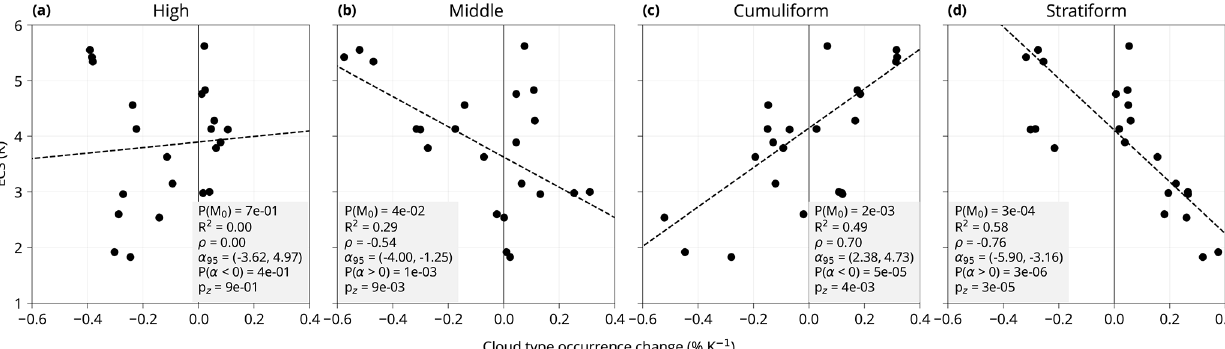
Figure 10. Dependence of model ECS on the cloud type occurrence change with respect to GMST. Confidence bands represent the 68% range. Linear regression is calculated using Bayesian simulation assuming a Cauchy error distribution (Appendix A). Shown is also the probability of the null hypothesis model P ( M 0 ) (explained in Sect. 4.6), the coefficient of determination ( R 2 ), the correlation coefficient ( ρ ), the 95% confidence interval of the slope ( α 95 ) of the linear regression, the probability that the slope is smaller or greater than zero, P ( α < 0) and P ( α > 0), and the p value of a z test ( p z ) for the difference in the means of two groups of models in the bottom 50% and top 50% of ECS. For some models, marked with “*”, ECS was not available and was taken from a related available model (see Table